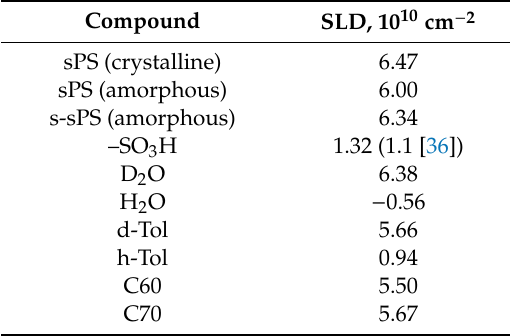
Table 1. The calculated scattering length density (SLD) for di ff erent components of the sulfonated synditoactic polystyrene (s-sPS)